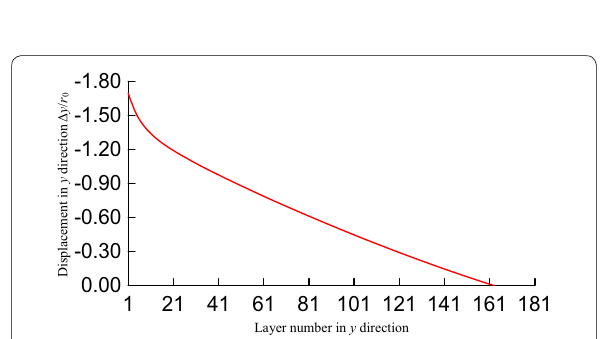
Figure 5 Displacements in y direction of atoms on the centerline of the substrate (227